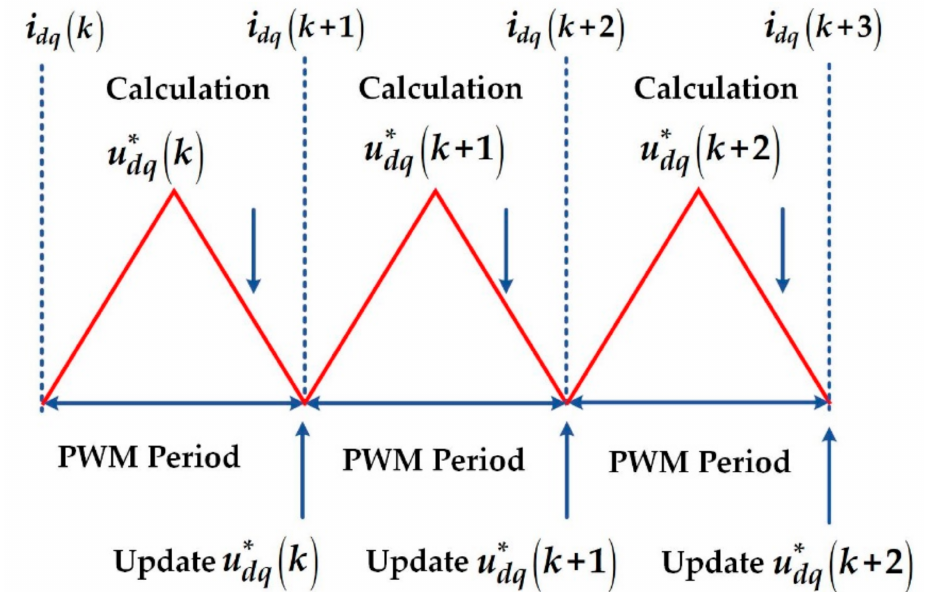
Figure 4. Time delay in SVPWM